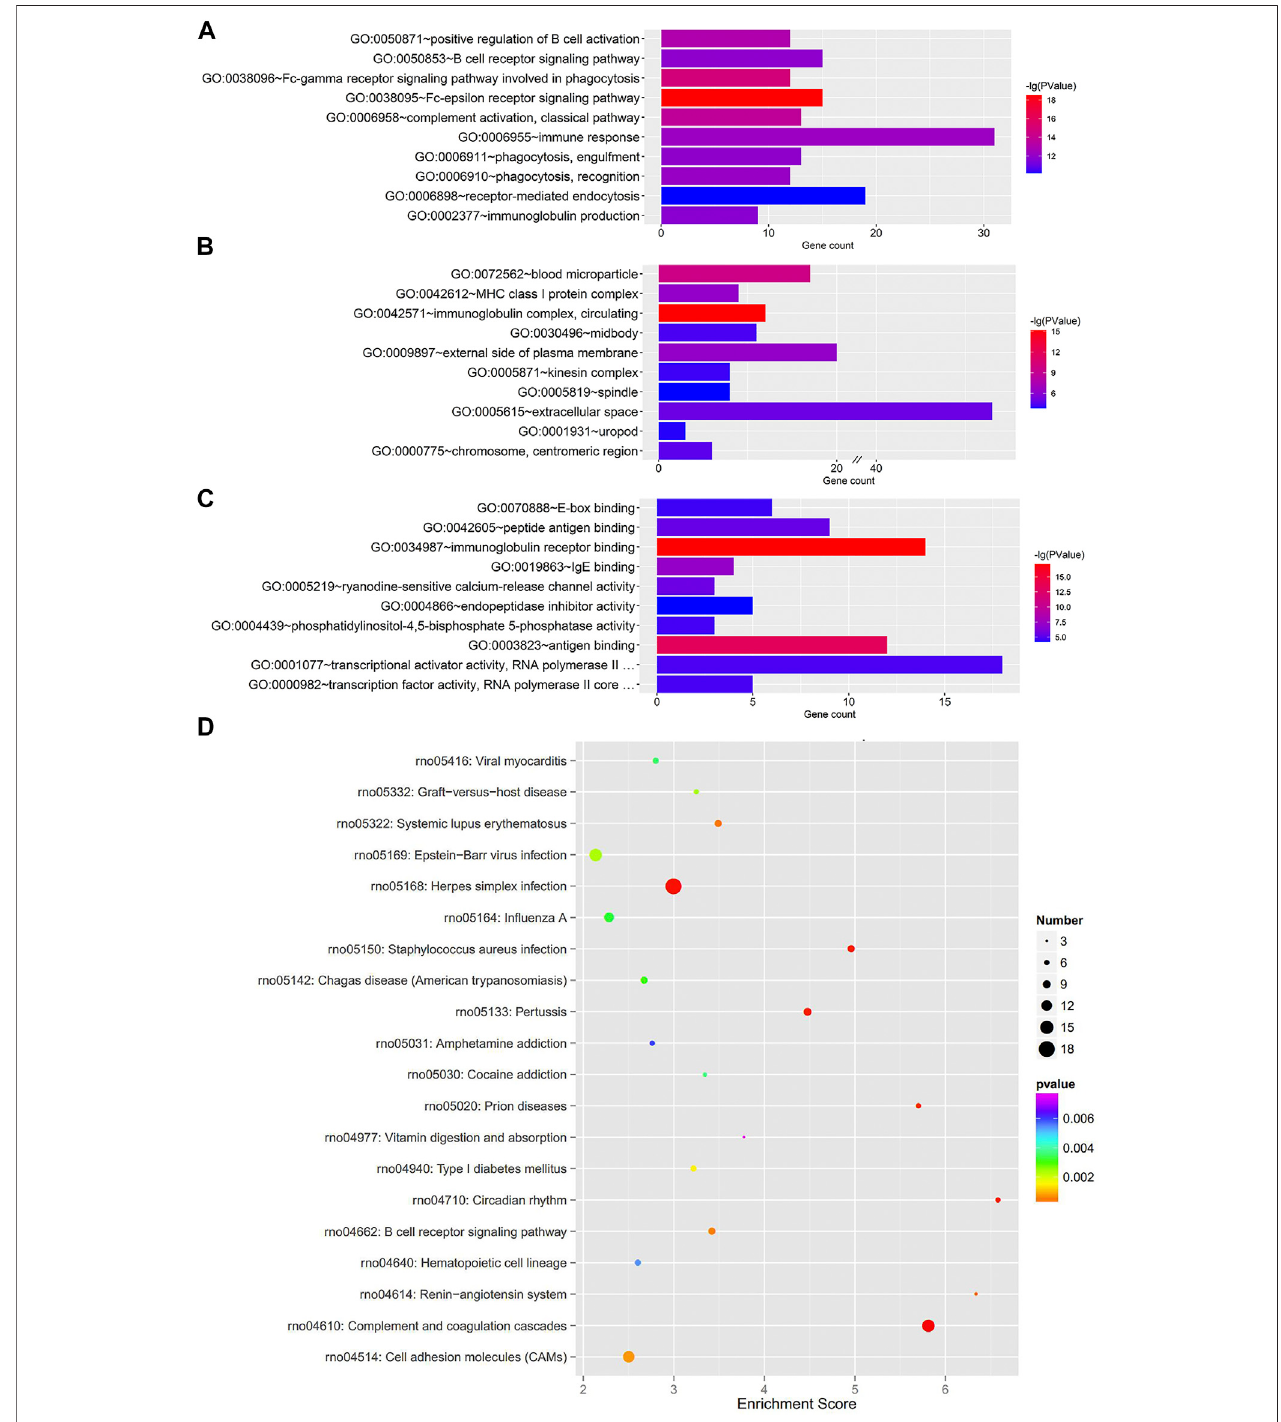
FIGURE 2 | GO enrichment and KEGG pathway analyses for the total dysregulated mRNAs. Top 10 enriched GO terms of total dysregulated mRNAs were presented according to (A) biological process, (B) cellular component and (C) molecular function, respectively. (D) KEGG pathway analysis of the total dysregulated mRNAs in